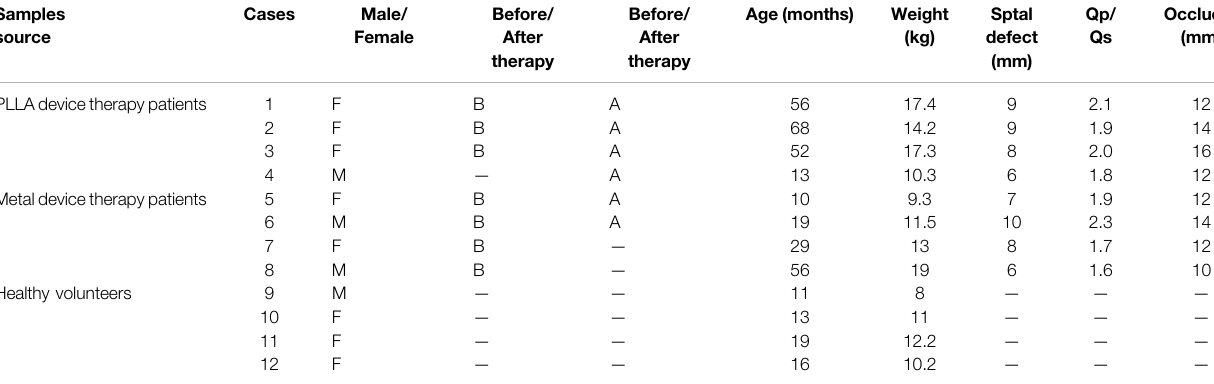
TABLE 1A | Basic characteristics of the patient samples of atrial septal defects used for RNA-sequencing analysis. Samples source